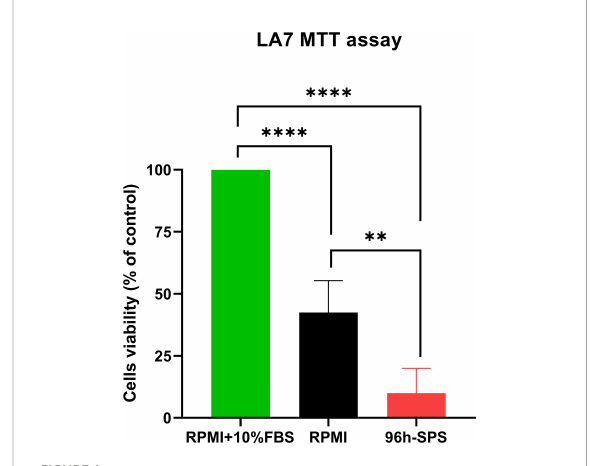
FIGURE 1 MTT assay showing the cytotoxicity of different treatments on the LA7 cell line. The 96 h-SPS treated cells showed the lowest level of viability compared with the RPMI group, p< 0.01, and positive control (RPMI + 10% FBS), p< 0.0001. Data expressed as mean ± standard error mean (SEM), bars indicate the SEM. In each panel. ** p < 0.01, **** p <